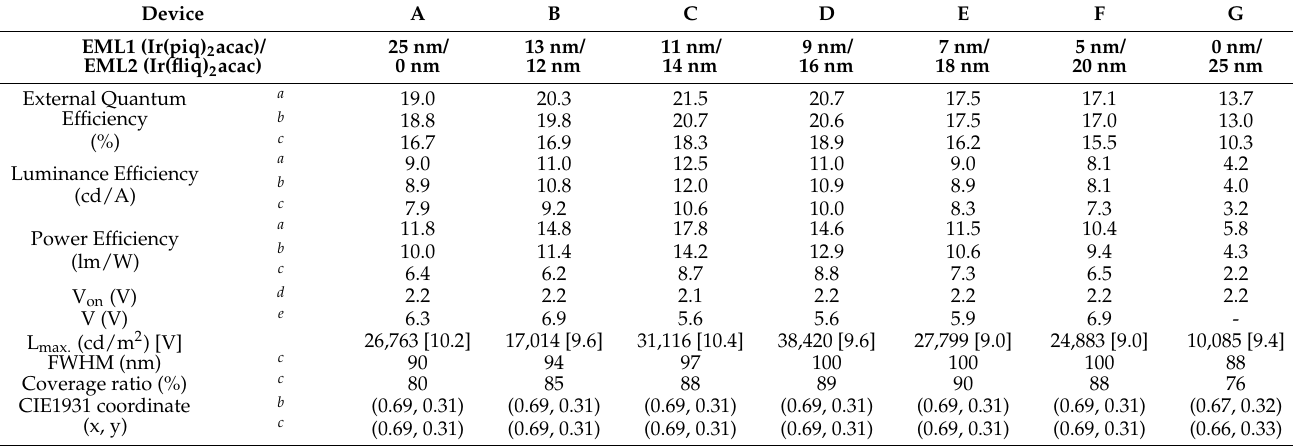
Table 1. EL characteristics of the tested red PhOLEDs with different thicknesses of the EML1 and EML2.